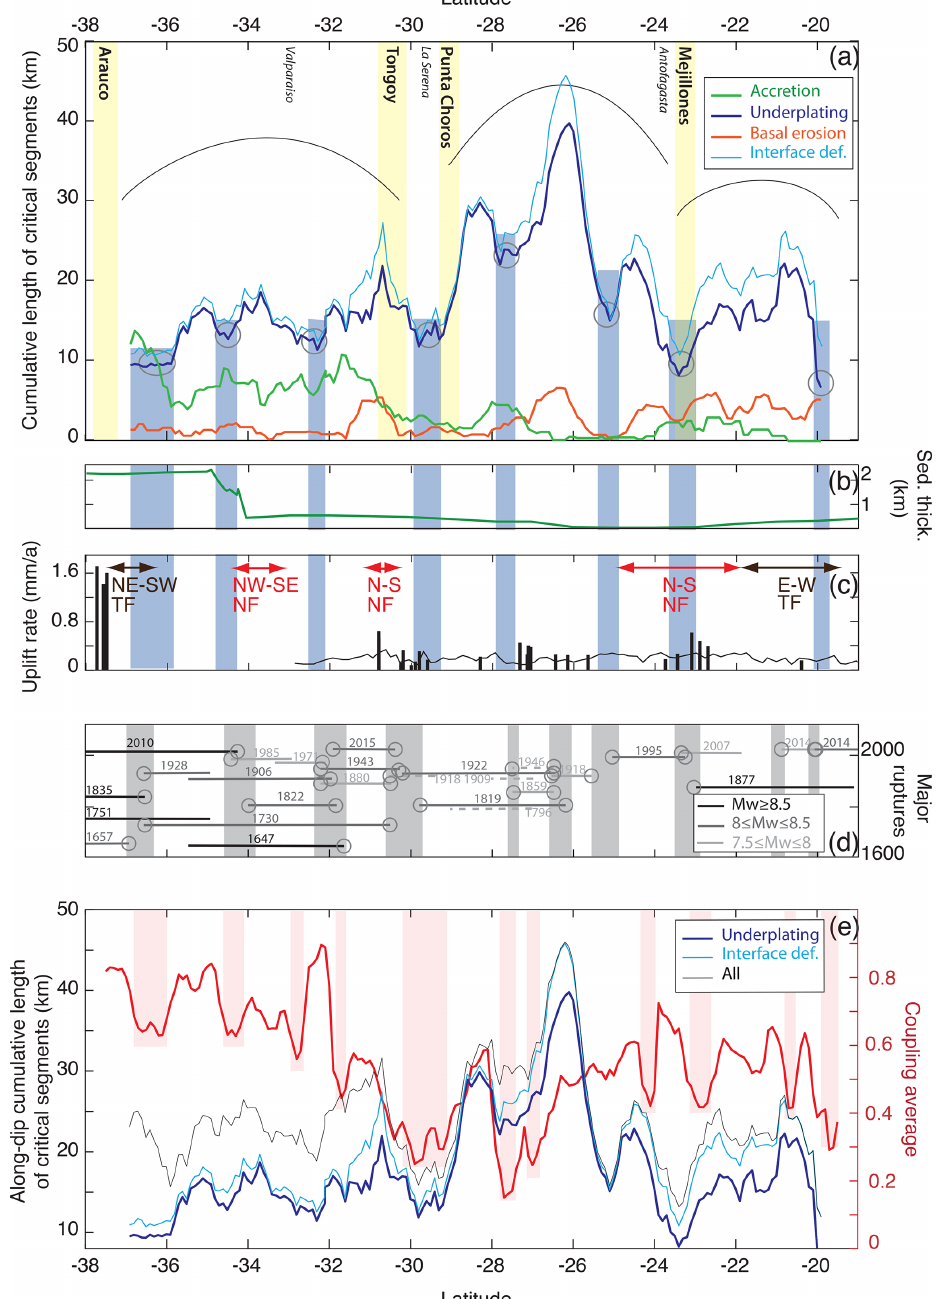
Figure 5. (a) Along-dip cumulative length of segments at accretionary (green), underplating (dark blue) or basal erosion (orange) critical state (length smoothed by a rectangular window over eight profiles). The light blue curve shows the cumulative length of segments with interface deformation (basal erosion + underplating). Regions with limited underplating (and interface deformation) length are represented by blue bands. (b) Thickness of sediment income (green; Santibáñez et al., 2018; Tréhu et al., 2019). (c) Quaternary uplift rates of marine terraces (black bars, largest average rate since terrace abandonment; Saillard et al., 2017), coastal uplift rate obtained from a landscape evolution model (black curve; Melnick, 2016) and extent of known active faults (NF: normal fault, TF: thrust fault; Santibáñez et al., 2018). (d) Along-strike extent of historical megathrust ruptures (Saillard et al., 2017). (e) Comparison between the cumulative length of segments at critical state (thin black), with underplating (thick blue), with both underplating and basal erosion (light blue) and the average coupling value along profiles from Metois et al. (2016) corrected by Klein et al. (2018) between 24.5 and 28 ◦ S (plain red curve). Red bands show segments of decreasing coupling. Correlation factor between coupling and underplating: r = − 0 . 36, between coupling and underplating + basal erosion: r = − 0 .